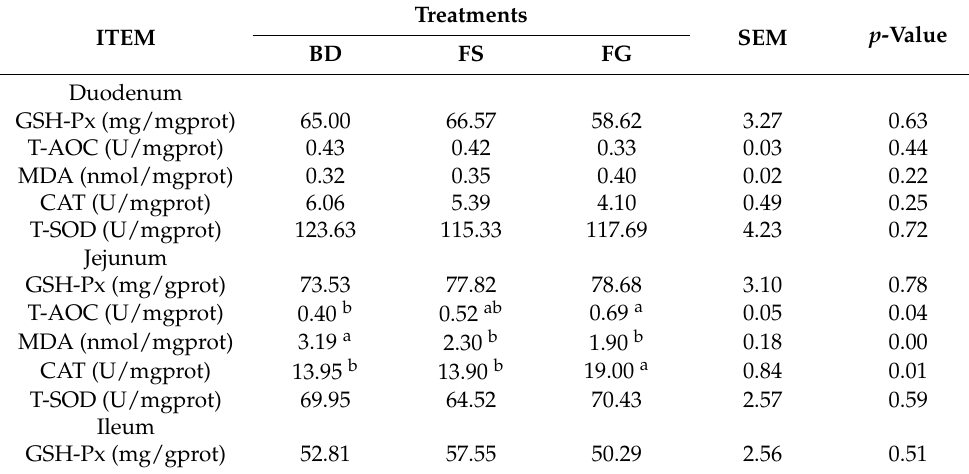
Table 6. Effect of different sources of iron on intestinal antioxidant in weaned pigs. Treatments ITEM SEM p -Value BD FS